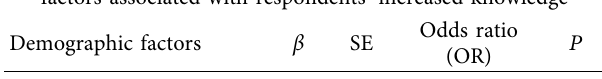
Table 5: Binary and multinomial logistic regression analyses of predictors likely to influence knowledge and perceived/perception of CKD risk factors among respondents. Section A. Binary logistic regression analysis of demographic factors associated with respondents’ increased knowledge